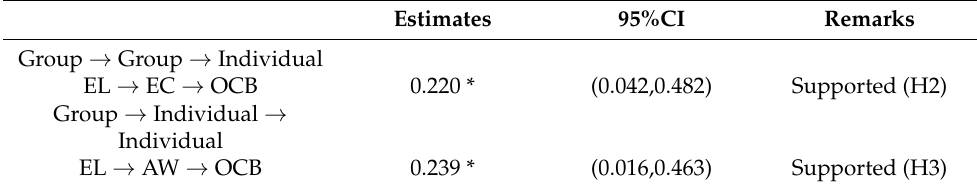
Table 4. Summary of mediation effects.